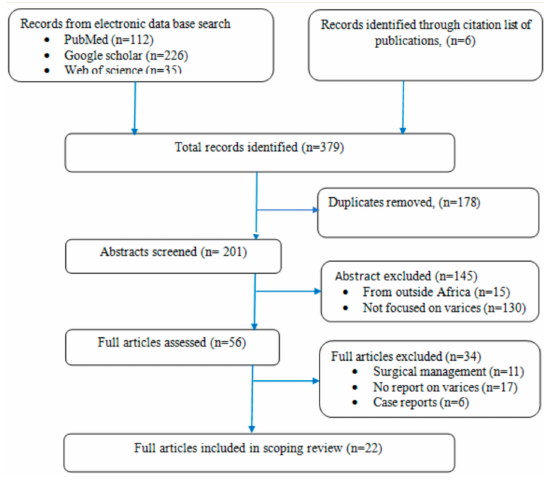
Figure 1. Flow chart indicating selection of articles included in this